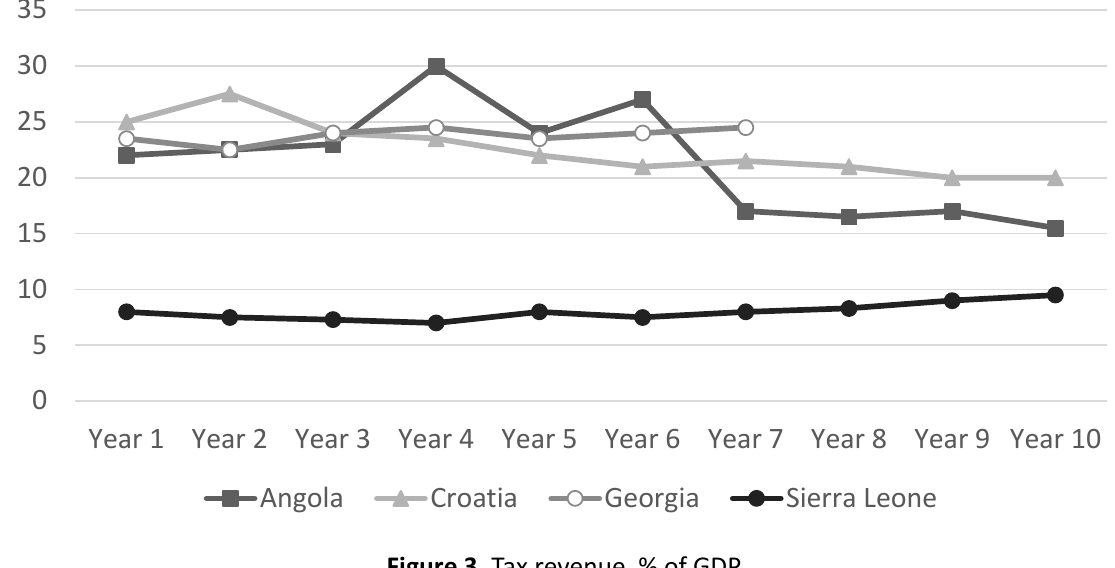
Figure 3. Tax revenue, % of GDP